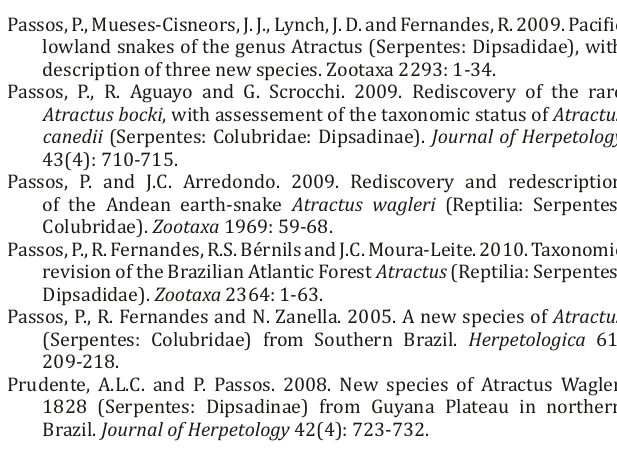
Distribution map of the species, made based on literature records of Passos et al (2012) and examined specimens from the collections ZUFSM and